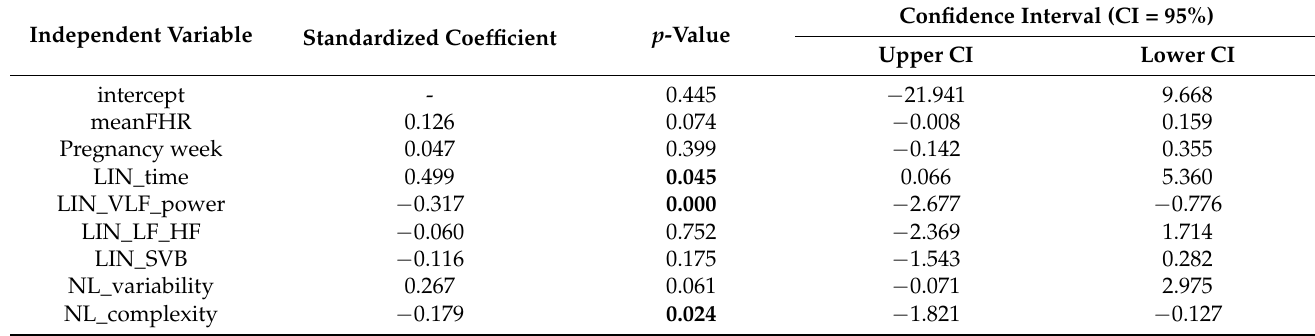
Table 6. Coefficient of the